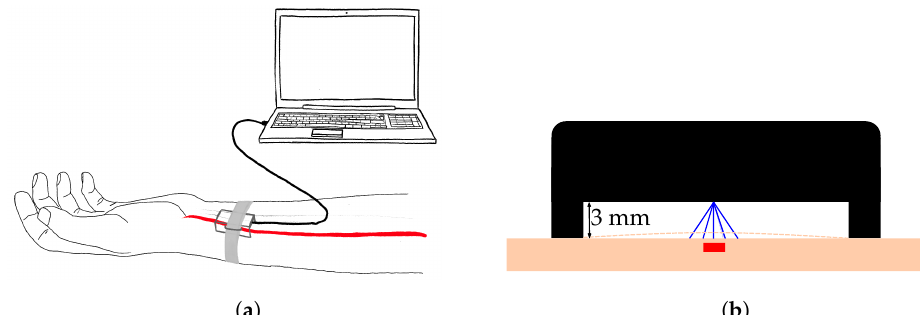
Figure 12. Visualization of the radar setup for data collection. ( a ) Radar positioning at the left wrist, above the radial artery. Radar is inside a 3D printed enclosure and streams the collected radar data to the PC via standard USB connection. ( b ) Close up view of the radar positioning. The red square represents the radial artery. The radar is located in the 3D enclosure (represented in black), with a standoff of 3mm. The blue lines represent the reflected electromagnetic waves from different directions.